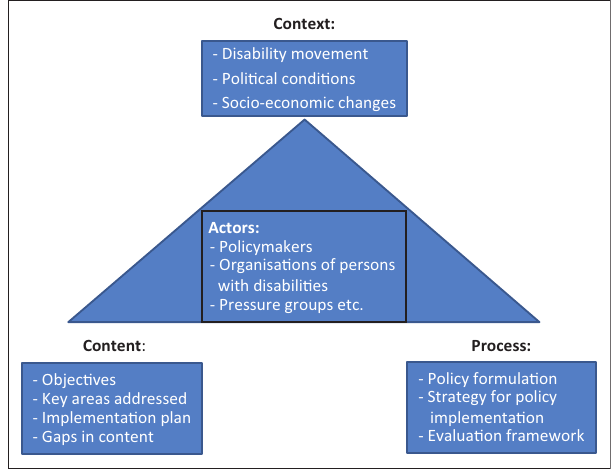
FIGURE 1: Policy triangle